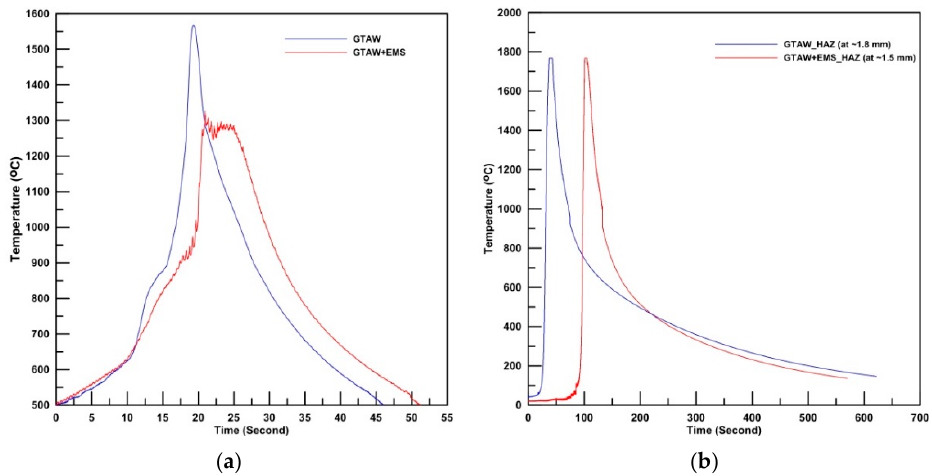
Figure 10. The temperature profiles of heat-affected zones (HAZs): ( a ) high-speed pyrometer [6] and ( b ) R-type thermocouple.